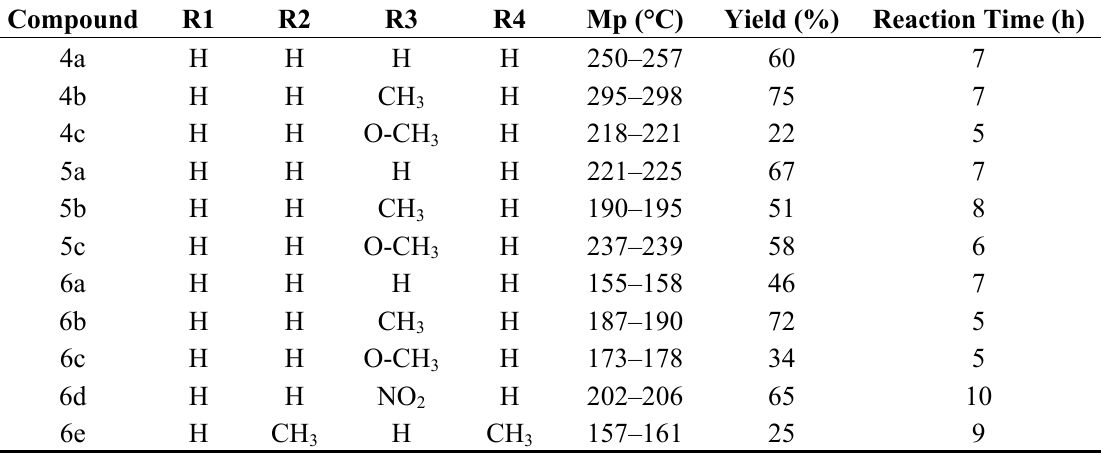
Table 1. Reaction times and yields of bis- THQs 4a (cid:31) c , 5a – c and 6a – e